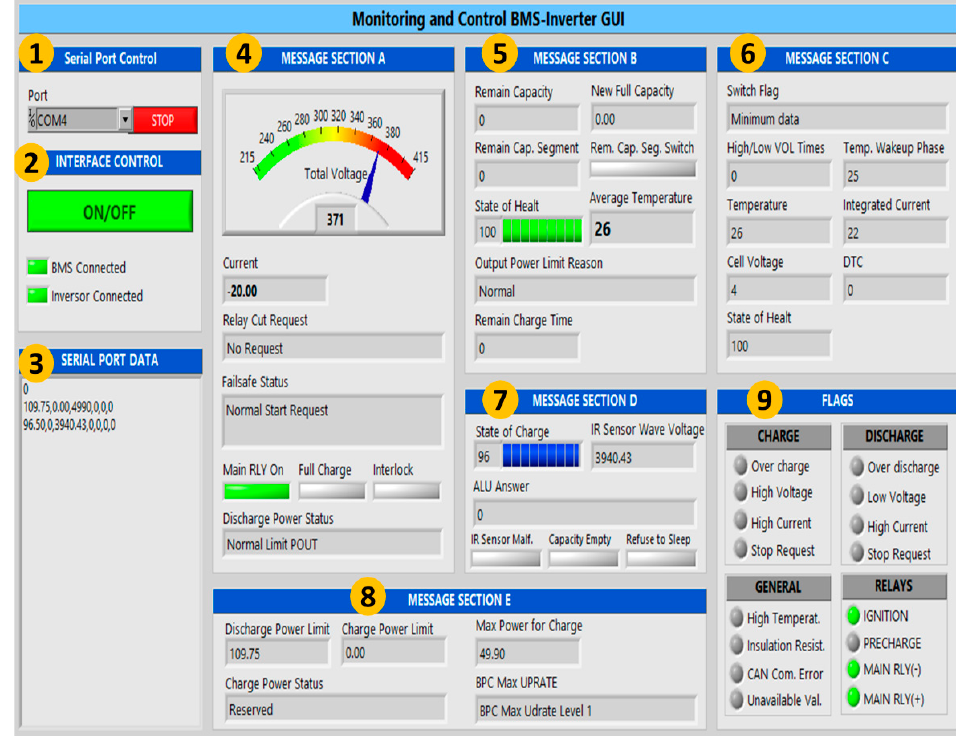
Figure 8. Monitoring and control BMS inverter GUI.